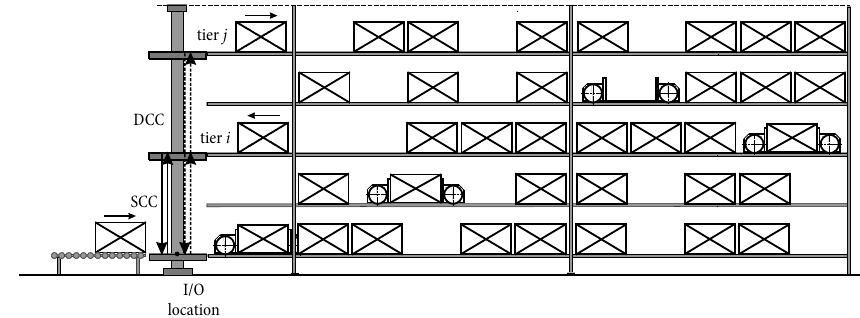
Fig. 2. SCC and DCC of the elevator’s lifting table (Lerher et al. 2015a)